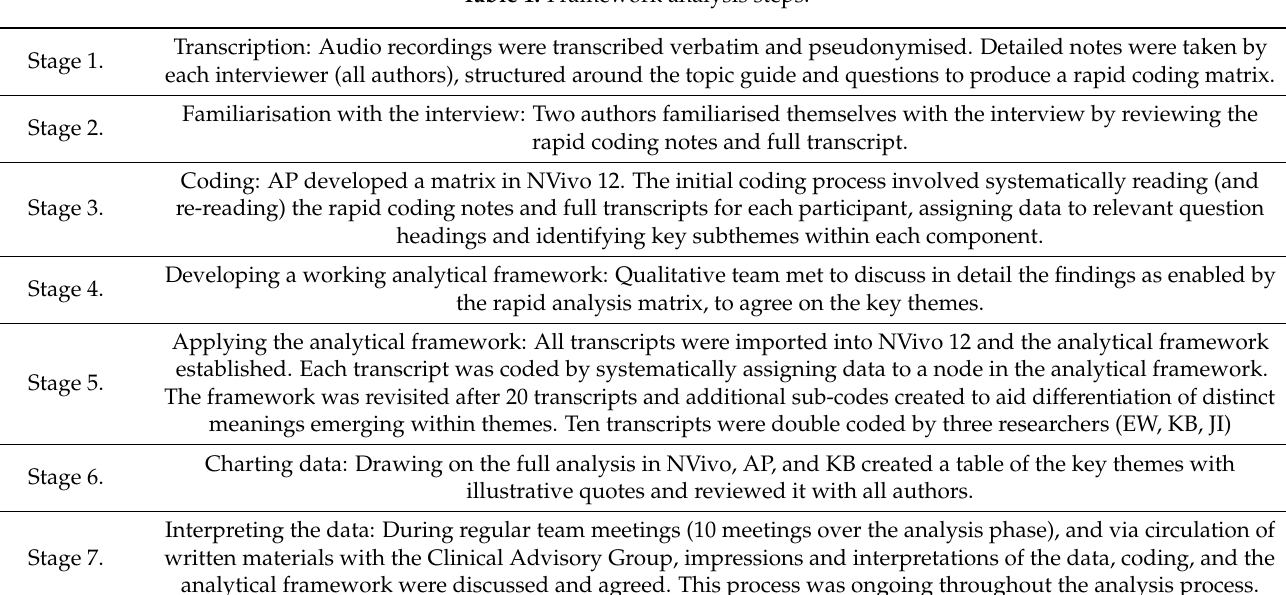
Table 1. Framework analysis